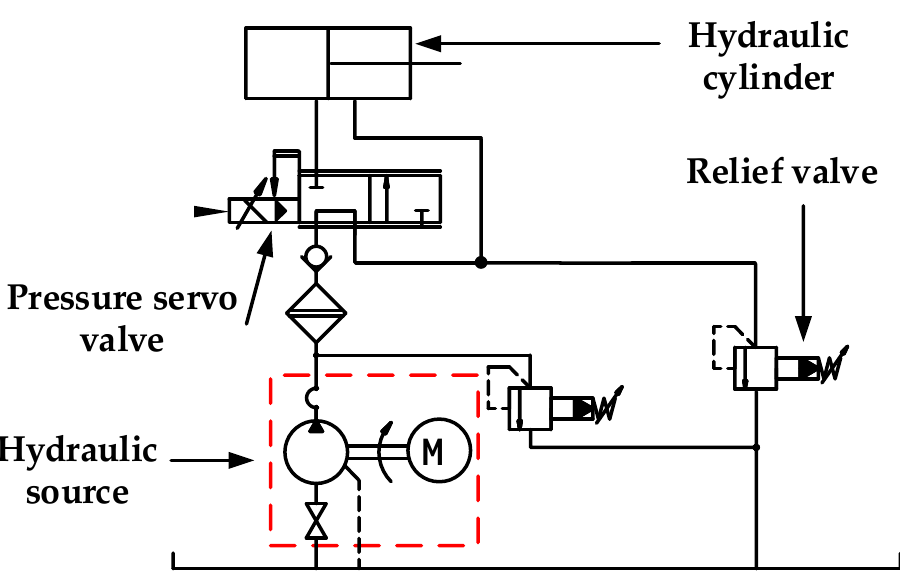
Figure 1. The hydraulic schematic diagram of PSVS.